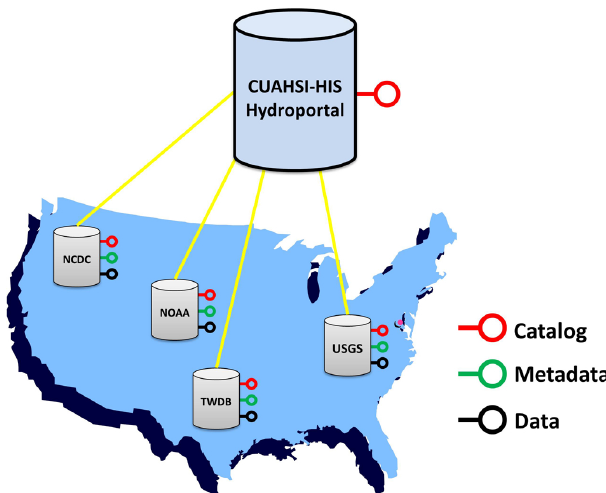
Fig. 9. Distributed CUAHSI-HIS